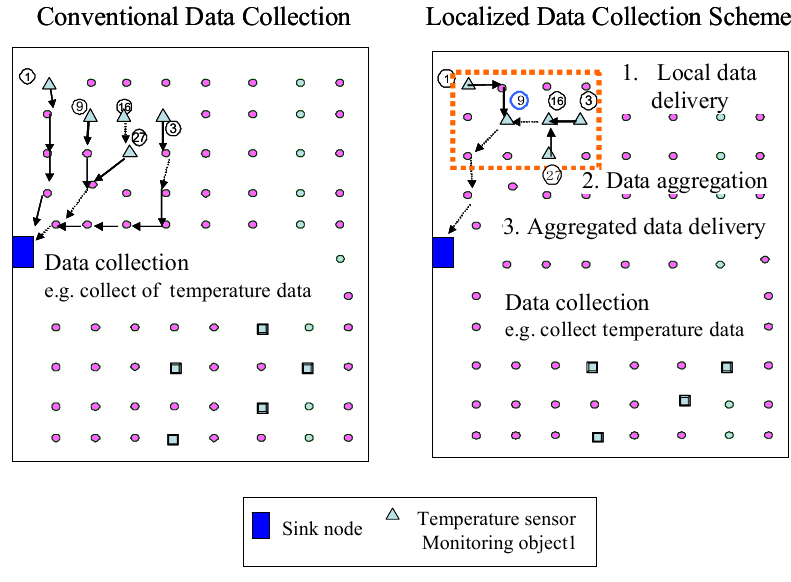
Figure 3. LSDC data